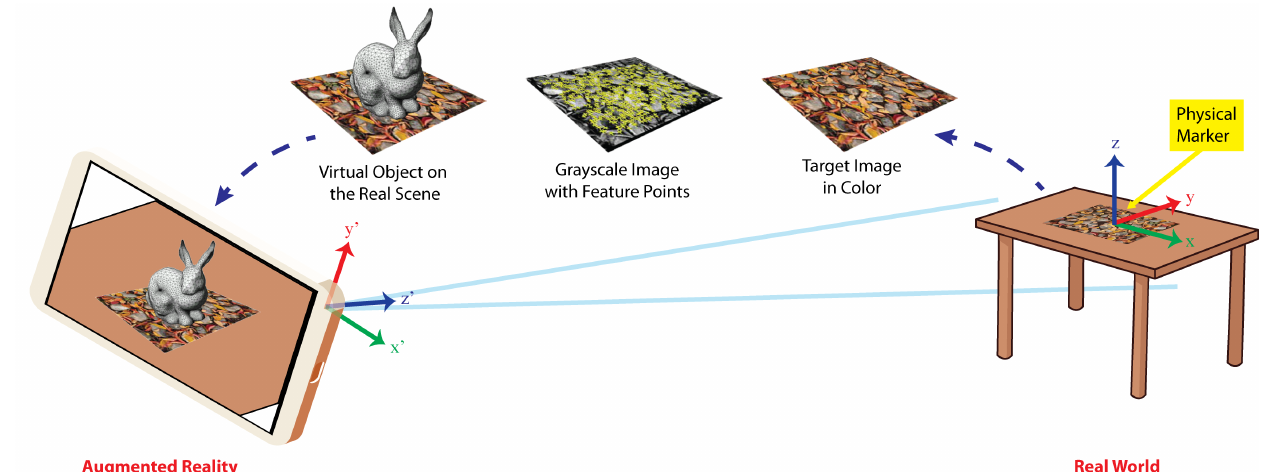
Figure 4. The target color image is taken from the real scene ( right ), then it is transformed to grayscale and its visual feature points in yellow are detected ( center ), and finally a virtual object is added on the real scene ( left